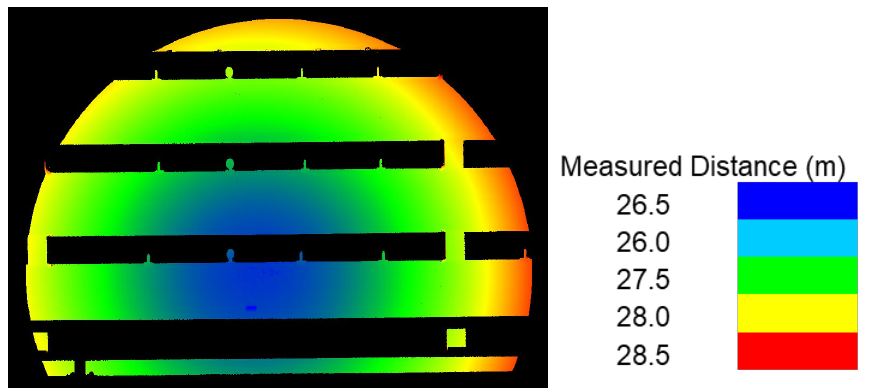
Figure 28. Raw observations of the Livox ® Mid–40 during outdoor experiments, colored by measured distance from scanner origin.